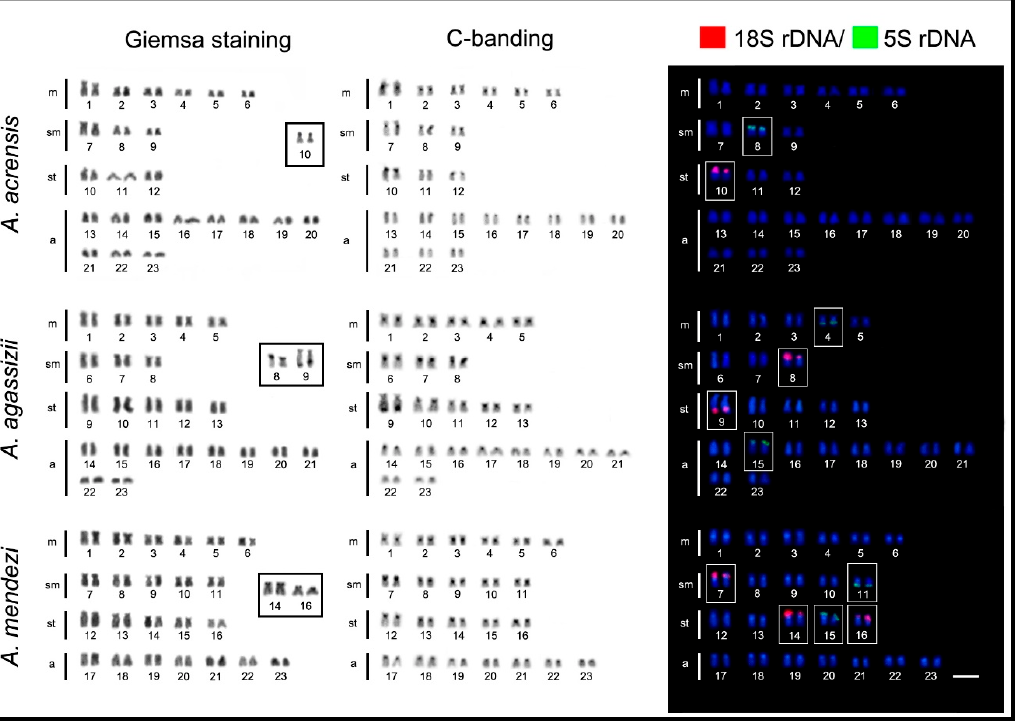
Figure 2. Karyotypes of Apistogramma acrensis, Apistogramma agassizii , and Apistogramma mendezi species arranged as described in Figure